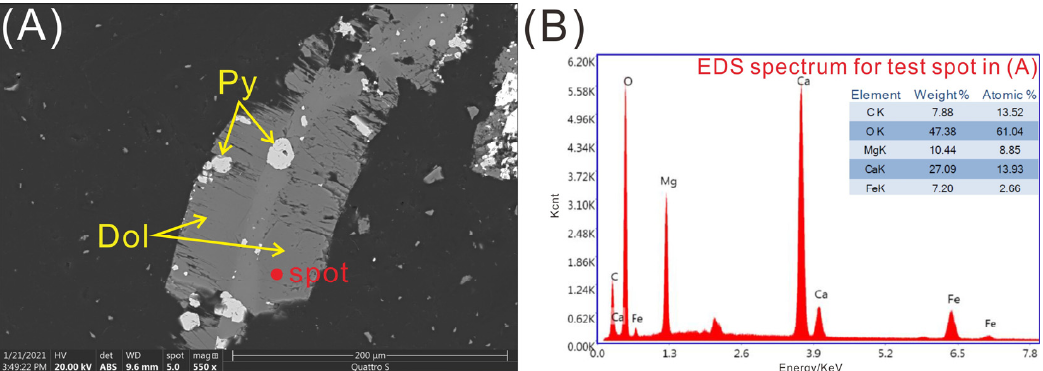
Figure 9. SEM back-scattered electron images of minerals in sample TN-10: ( A ) pyrite and dolomite; ( B) EDS data and spectrum for point in A. Dol, dolomite; Py, pyrite.